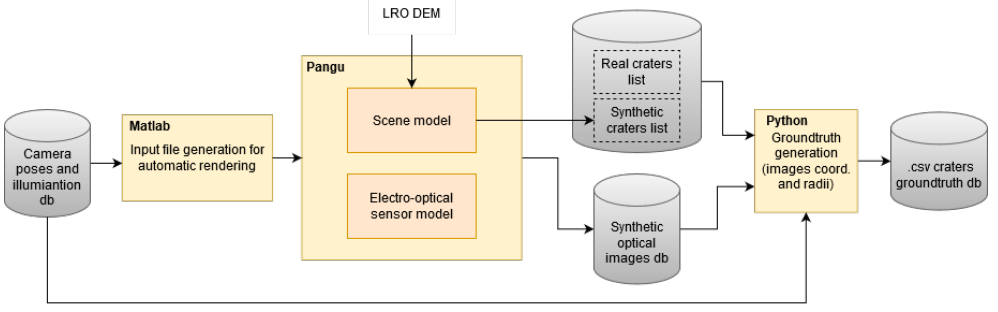
Figure 9. Synthetic images generation tool for relative terrain navigation testing.